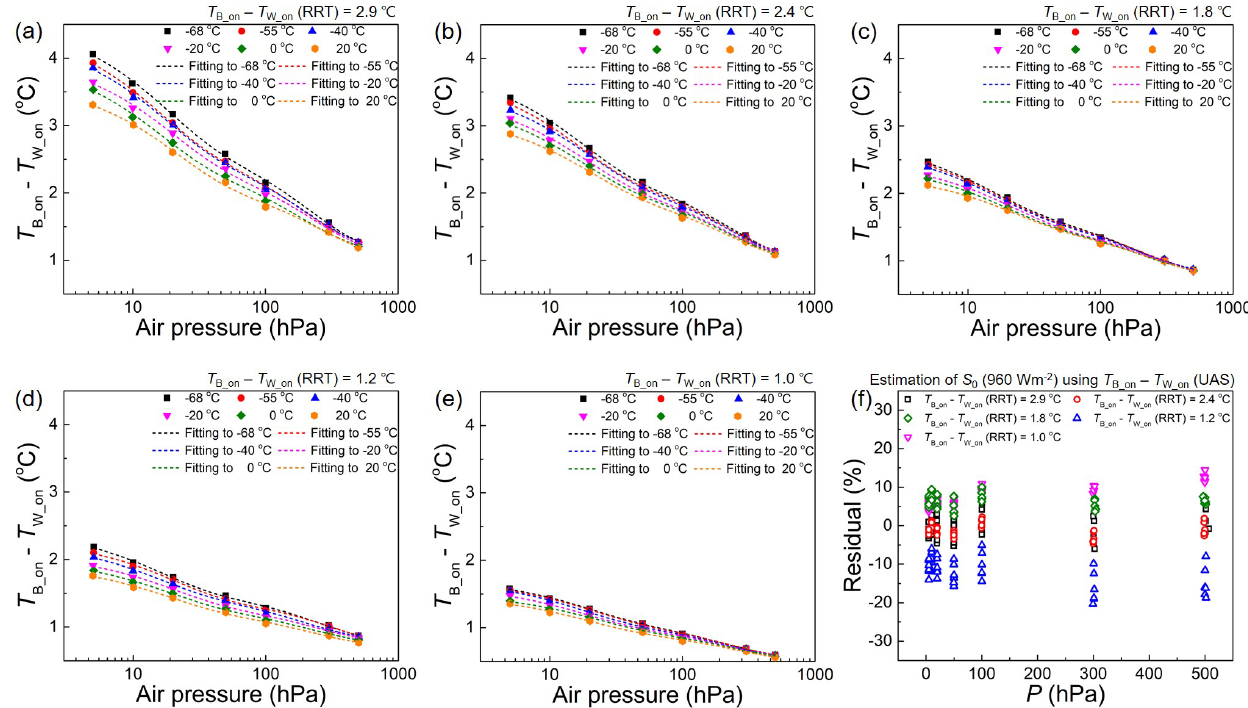
Figure 6. Temperature differences between paired white and black sensors ( T B_on − T W_on ) investigated using UAS. (a–e) ( T B_on − T W_on ) of the five paired radiosonde thermistors as a function of air pressure with varying temperature. (f) Residual irradiance calculated on the basis of ( T B_on − T W_on ) obtained in UAS and the rotational radiation